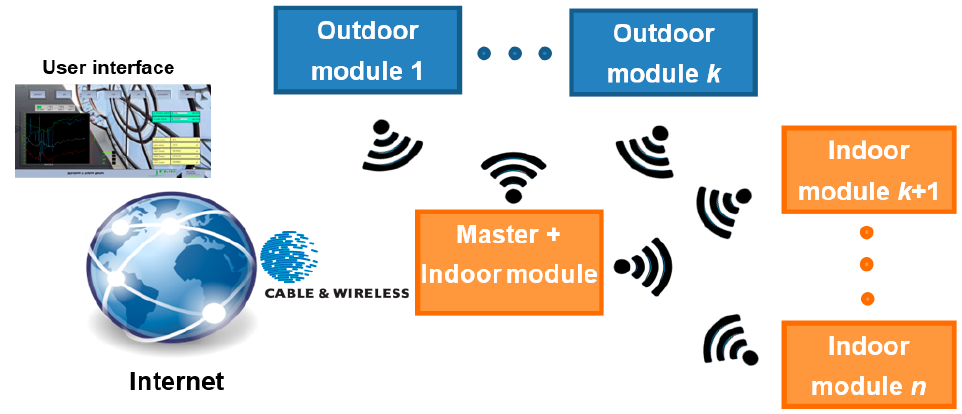
Figure 2. Developed U-Value metre.